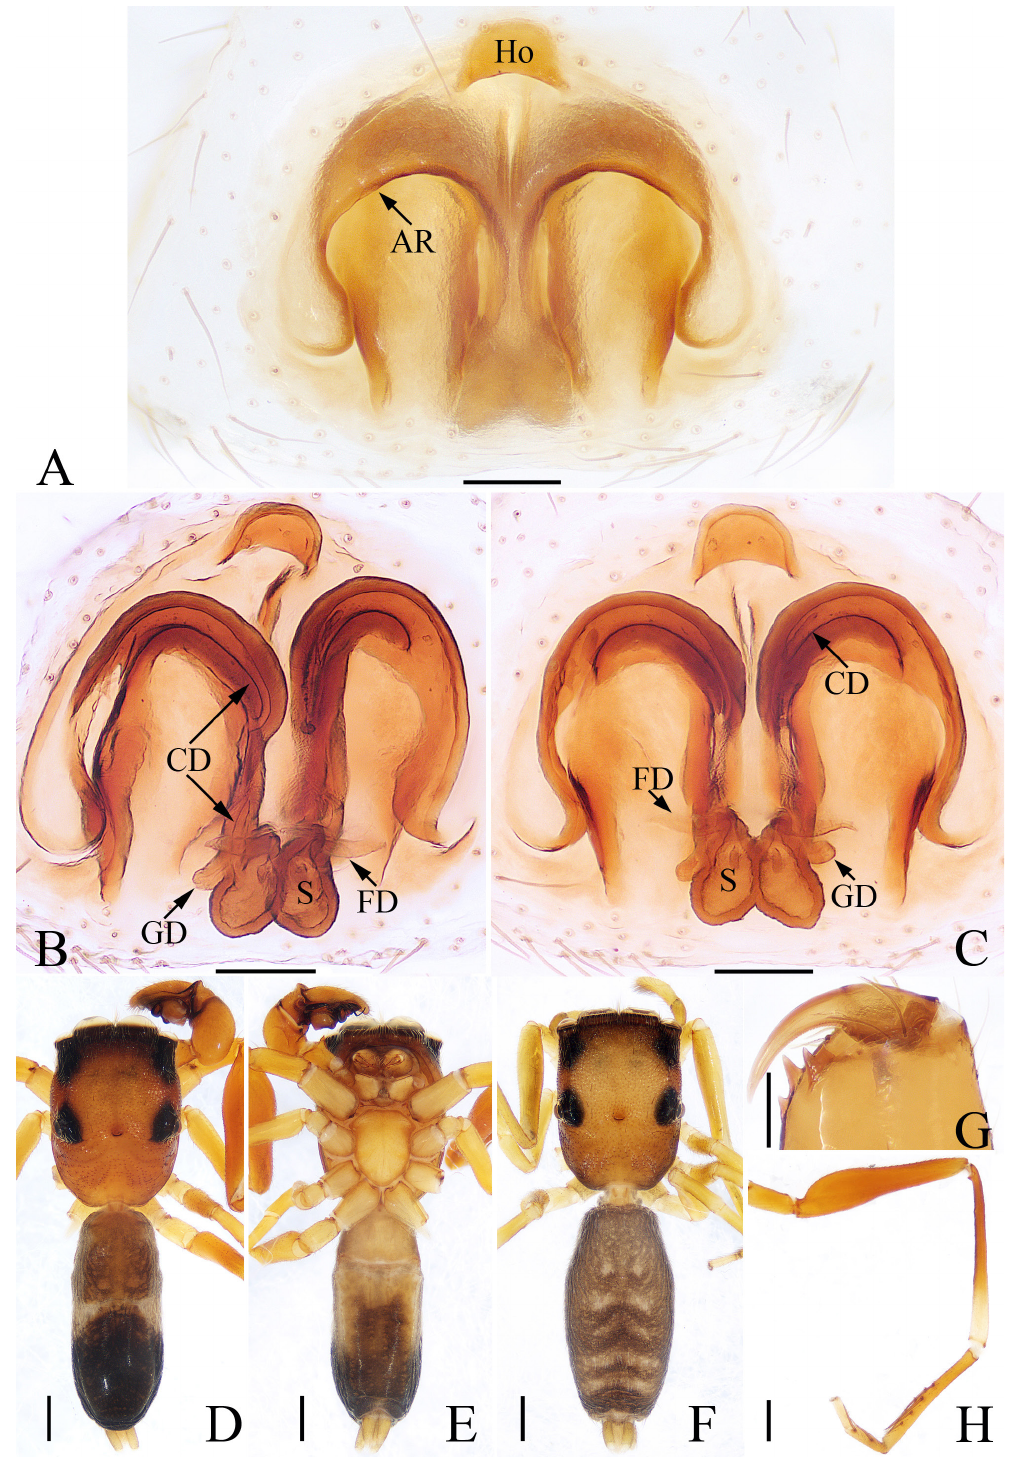
Fig. 10. Synagelides longus Song & Chai, 1992. A–C, F . ♀ (TRU-Salticid-0024). D–E, G–H . ♂ (TRU- Salticid-0020). A . Epigyne, ventral view. B . Epigyne, dorsolateral view. C . Epigyne, dorsal view. D . Habitus, dorsal view. E . Habitus, ventral view. F . Habitus, dorsal view. G . Chelicerae, dorsal view. H . Leg I, prolateral view. Abbreviations: see Material and methods. Scale bars: A–C, G = 0.1 mm; D–F, H = 0.5